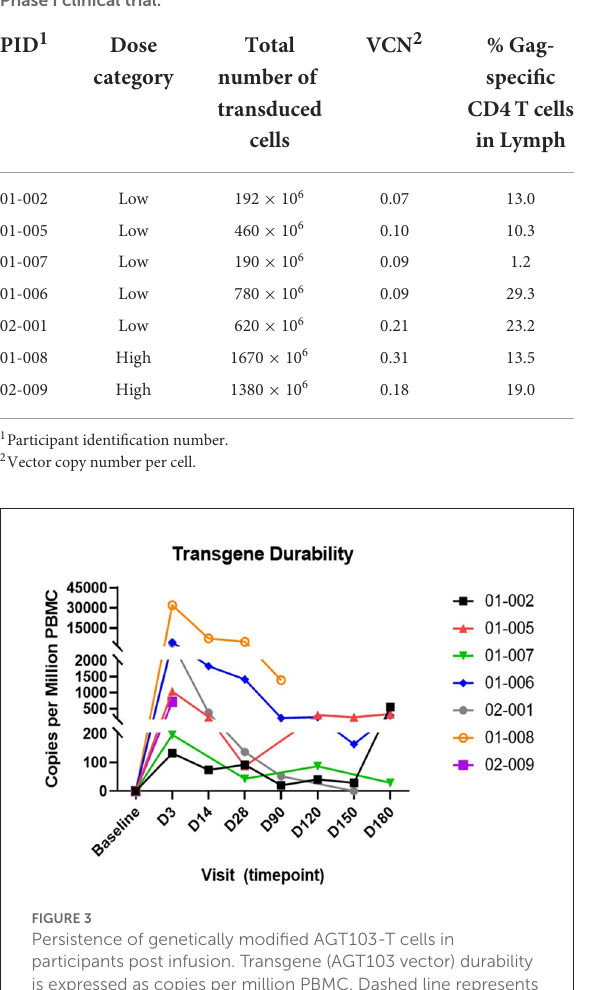
TABLE 5 Characteristics of individual AGT103-T cell products in the Phase I clinical trial.